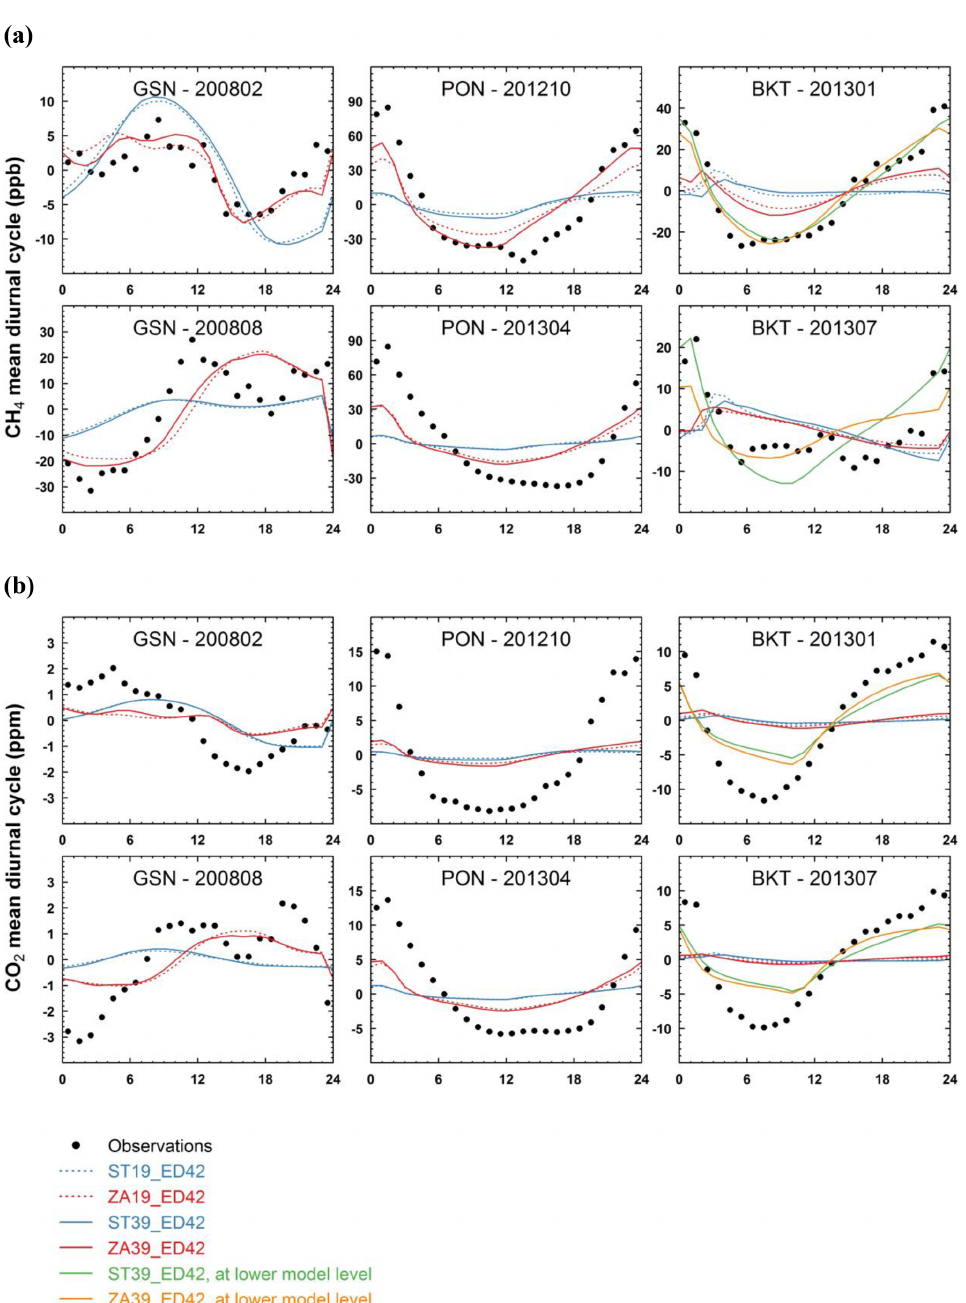
Figure 5. The observed and simulated mean diurnal cycles (in UTC time) of CH 4 (a) and CO 2 (b) at three stations within the zoomed region. For BKT, the simulated diurnal cycles at lower model levels are also